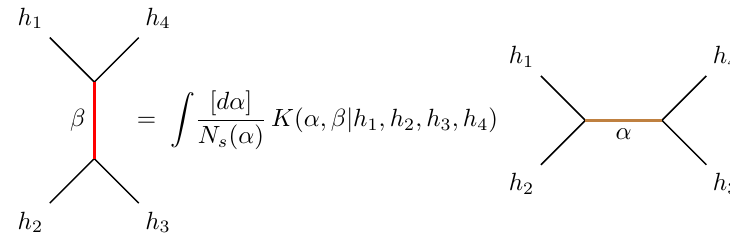
Figure 3 . Graphical representation of the crossing kernel K ( (cid:11); (cid:12)